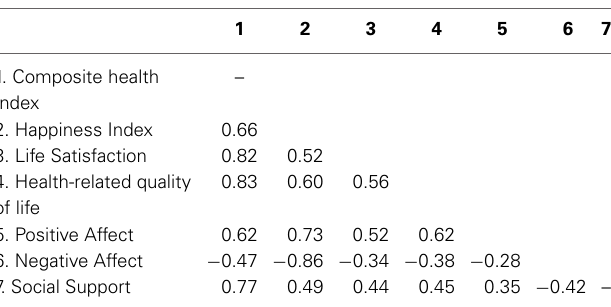
Table 4 | Correlations between measures of well-being.